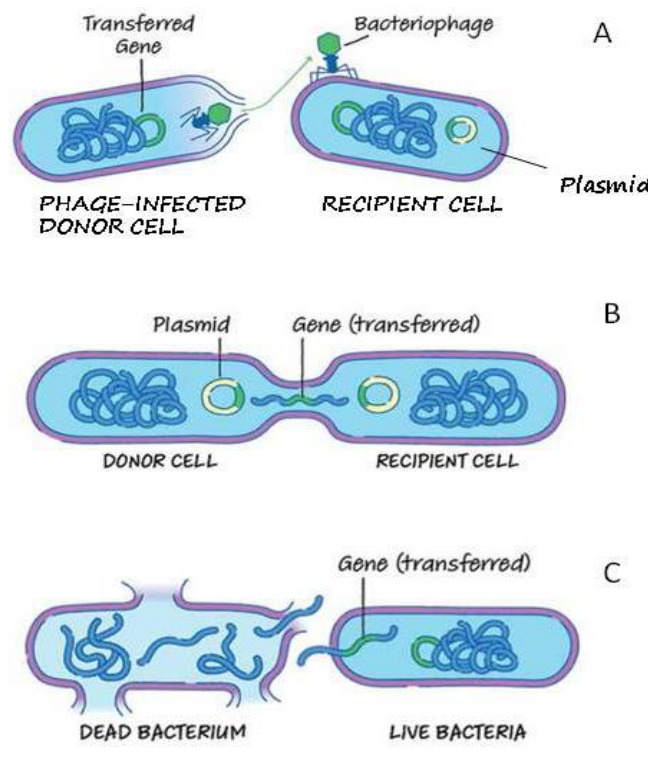
Figure 3. Scheme of the mechanisms of antimicrobial resistance genes (ARGs) transfer that are usually involved in bacterial cells: transduction, conjugation and transformation [76]. These mechanisms can occur also in the aquatic environment among autochthonous bacteria (aquatic bacterial species) and human pathogenic species that are temporally present in the aquatic environment. In the transduction process ( A ), a mature bacteriophage can move bacterial (virulence, antimicrobial resistance (AR), metabolism) genes to a new host cell. These genes can also be captured in a plasmid and spread by conjugation. In the mechanism of conjugation ( B ), a plasmid containing integrons, ISs, or transposons carrying ARGs can be transferred by ssDNA intermediate from a donor to a recipient cell. Also ICEs can use this mechanism followed by integration in the bacterial chromosome. During the transformation ( C ), the bacterial lysis can release DNA encoding for ARGs in the aquatic environment. This exogenous DNA can be captured from natural competent bacteria and integrated in their